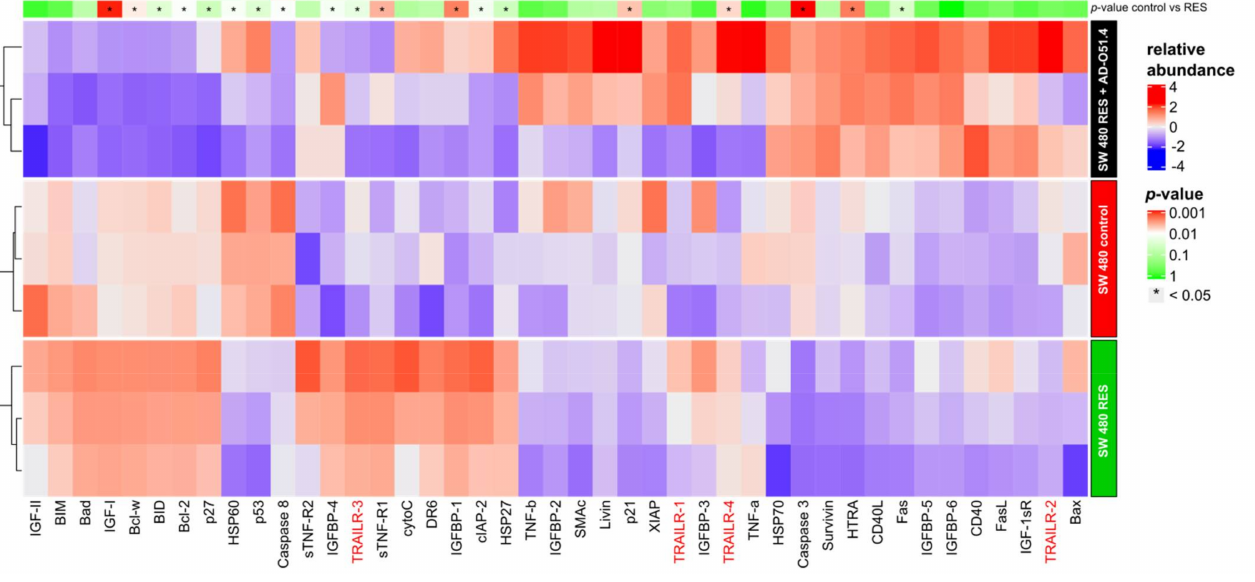
Figure 7. Quantification of apoptosis-related proteins using Human Apoptosis Antibody Array-membrane lysates (500 µ g) were processed on the antibody array membrane according to the manufacturer’s recommendations. Blots collected from SW480 native and SW480 cells with acquired resistance to AD-O51.4 cultured with or without AD-O51.4 were subjected to densitometric analysis. The raw blot images files are available at the Figshare repository https://doi.org/10.6084/m9